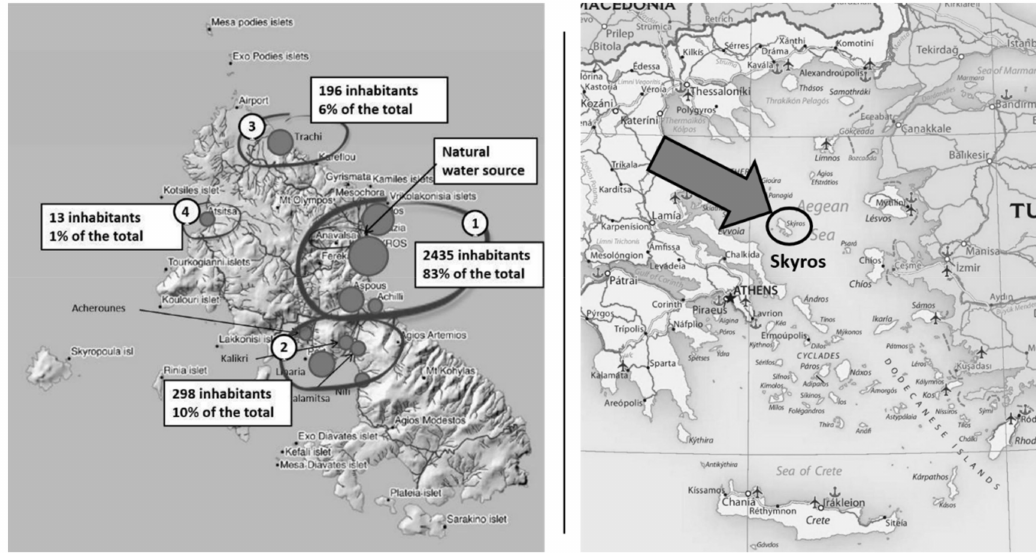
Figure 1. Defined water zones of the island of Skyros.